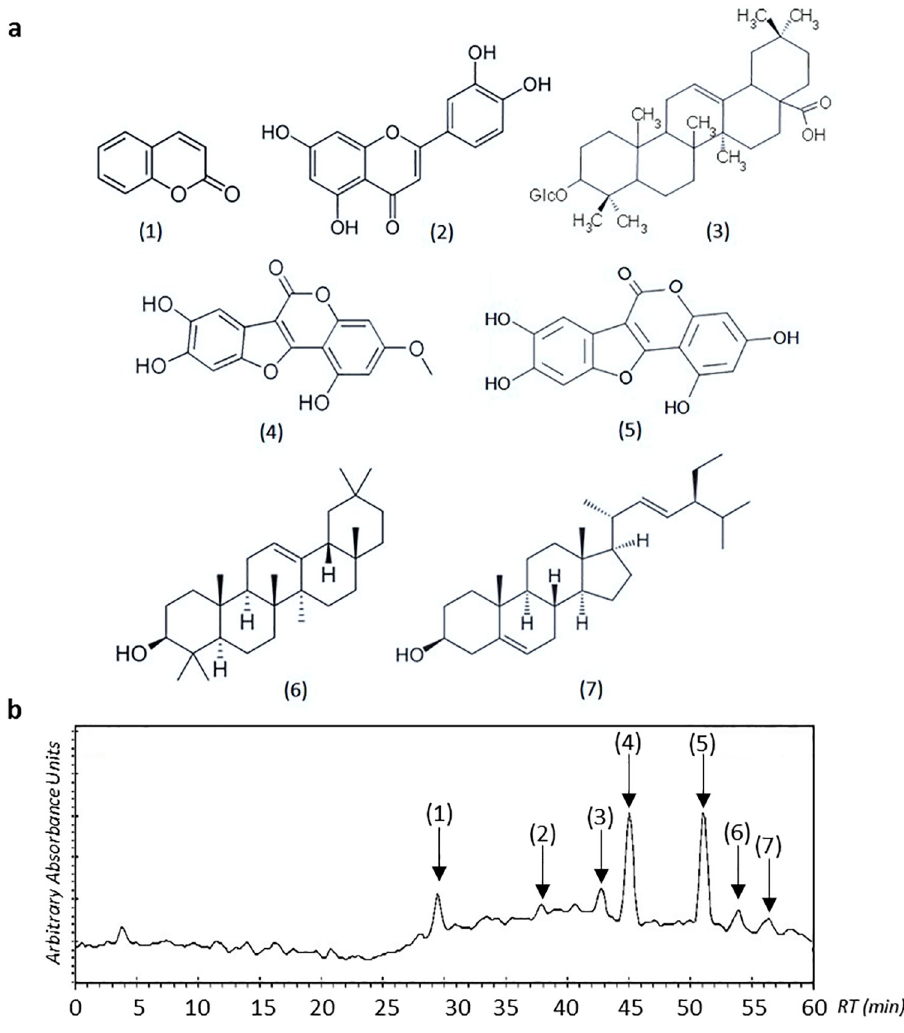
Fig 6. a) Structures of the main phytochemicals detected at 204 nm in methanolic extract of E . alba callus [(1): Coumarin; (2): Luteolin; (3): Eclalbatin; (4): demethylWedelolactone; (5): Wedelolactone; (6): β -amyrin; (7):